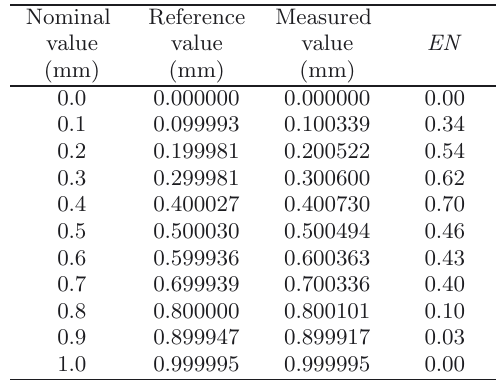
Table 4. Validation of the results for the image registration method of the 1 mm